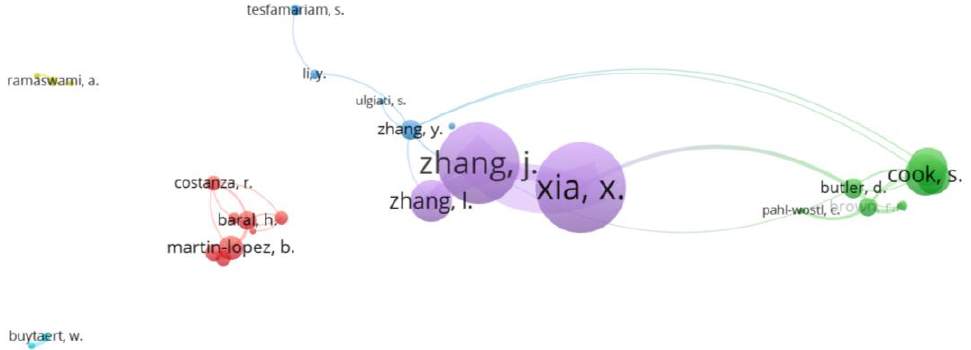
Figure 8. Authors’ network in the selected sample according to co-citation. Data from Scopus, visualizing by VOSviwer 1.6.18.